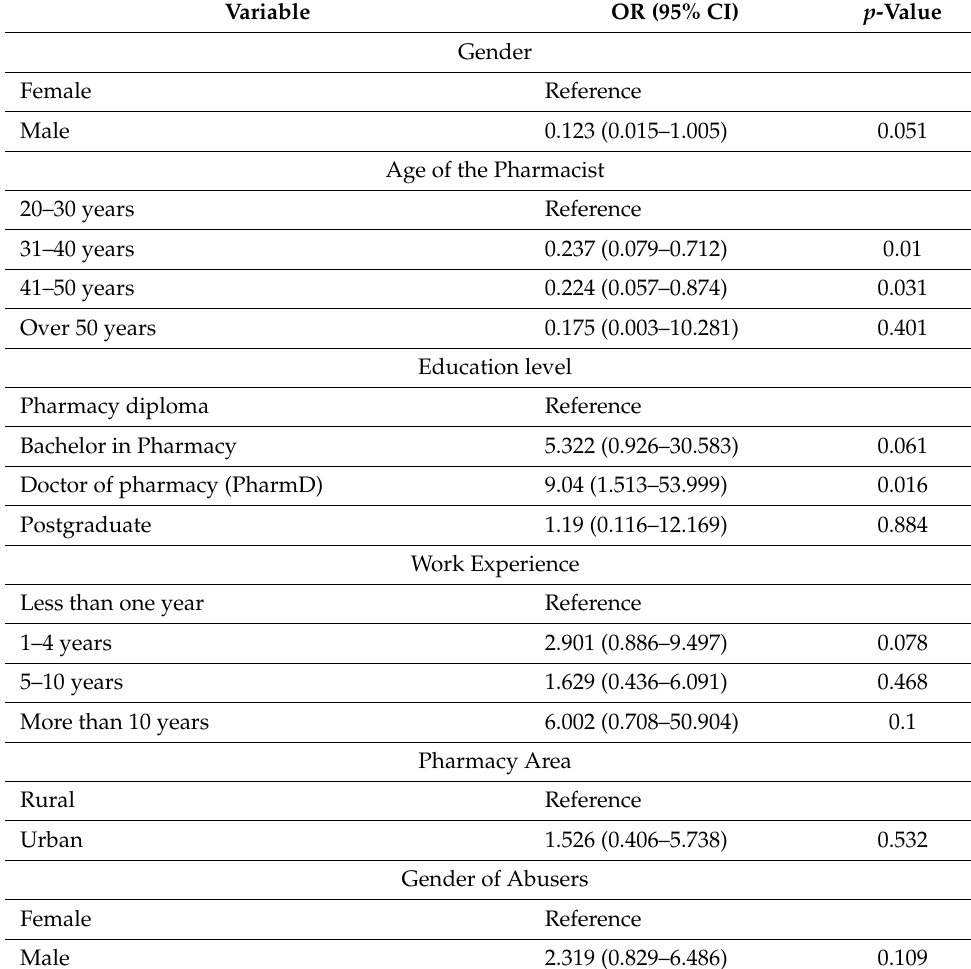
Table 7. Multiple logistic regression examining potential factors affecting the strategy used to limit suspected abusers’ access to pregabalin products (if OR is more than 1, this means that the odds of correct behavior, i.e., not selling pregabalin, was higher in this group compared to the